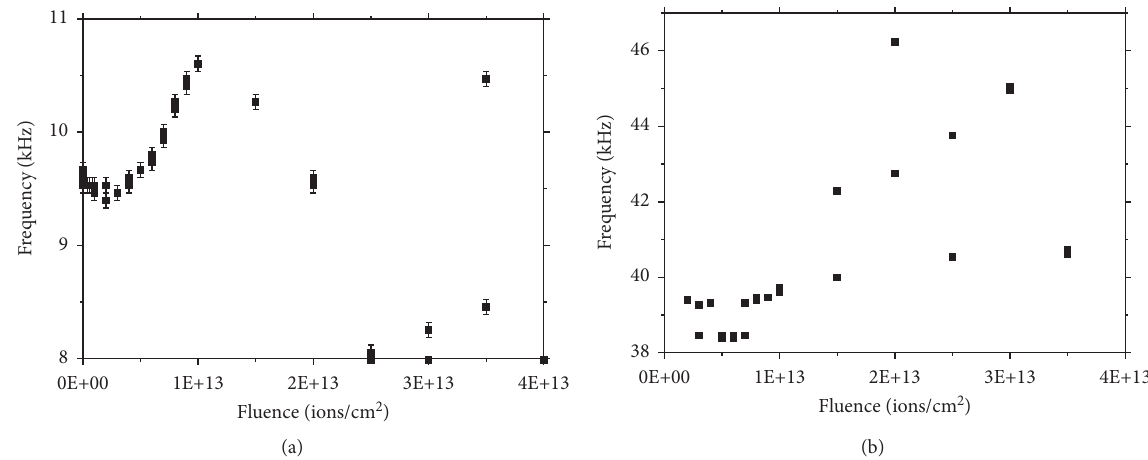
Figure 10: Measured frequency of the bending mode as a function of fluence for h-BN irradiated with 1.14GeV U-ions: (a) low-frequency signal around 10 kHz and (b) high-frequency signal around 40kHz. The large signal fluctuations above 1 × 10 13 ions/cm 2 are ascribed to fragmentation/detachment of the irradiated inner section of the sample. The uncertainty of the frequencies is due to the limited frequency resolution of the FFT.